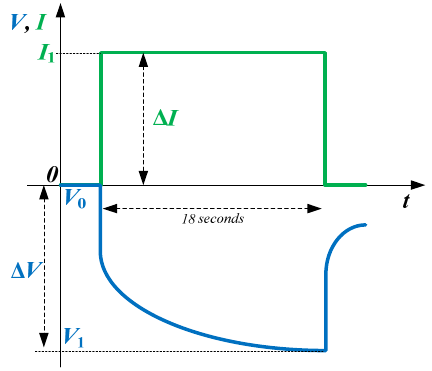
Figure 7. Theoretical voltage and current of Li-ion battery during impedance measurement with the current pulse technique.